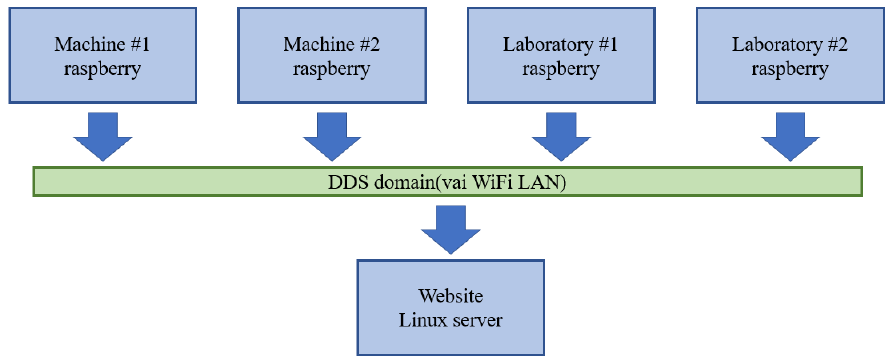
Figure 3. Data acquisition for different locations.